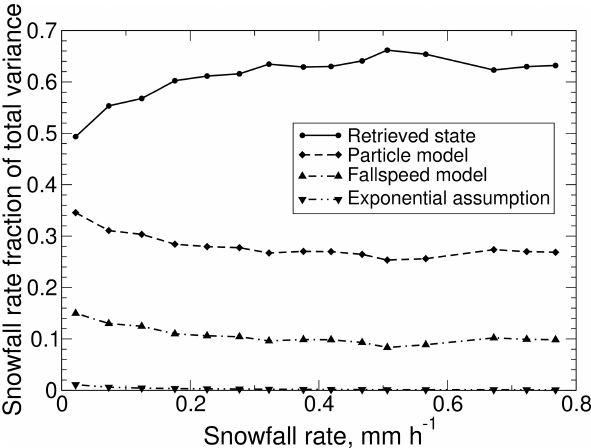
Figure 11. Instantaneous fractional variances for snowfall rate re- solved by source.